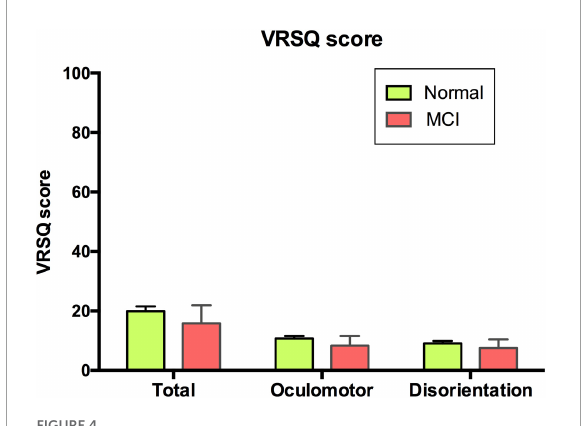
FIGURE4 VRSQ total and sub-scores of each group. VRSQ, Virtual Reality Sickness Questionnaire; MCI, mild cognitive impairment.